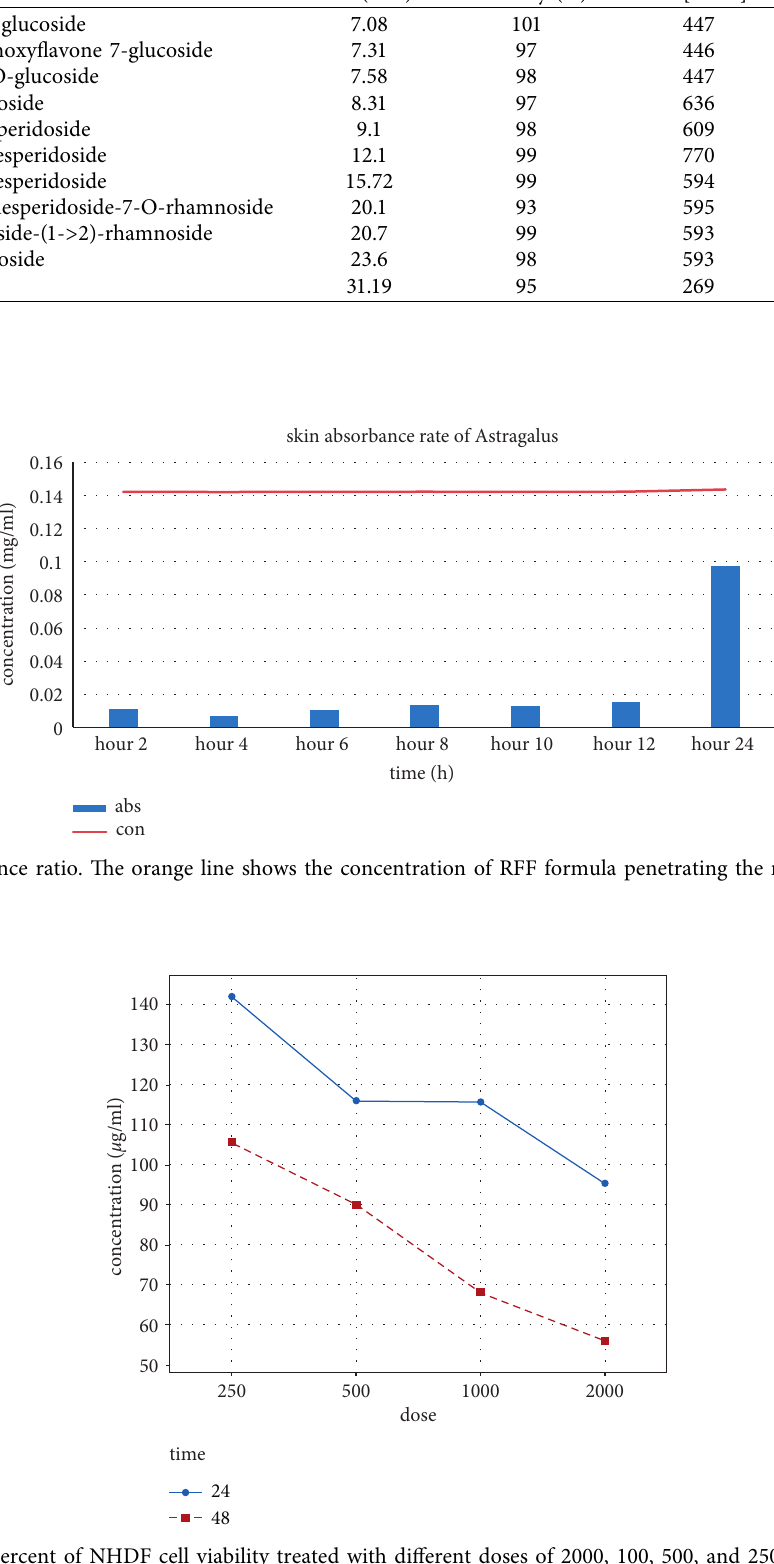
Table 1: The LC-MS peaks information, retention time (RT) values, [ M + H ] + , and concentration. Peak IDs